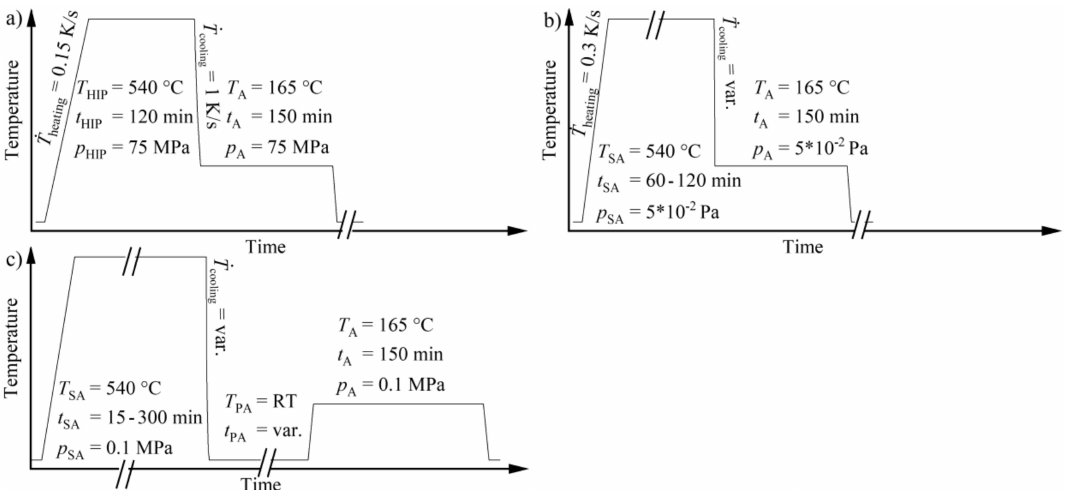
Figure 3. Schematic depiction of the applied heat treatments: ( a ) hot isostatic press; ( b ) dilatometer and induction furnace; ( c ) resistance